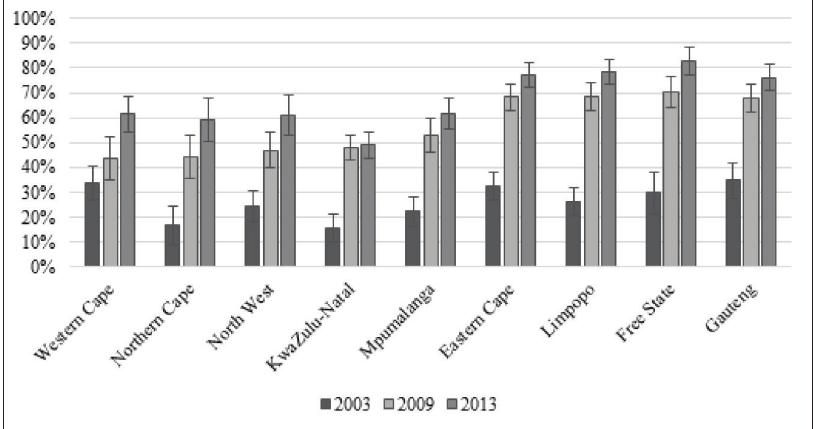
Figure 3: Educare participation among four-year-olds by province (Source: SSA